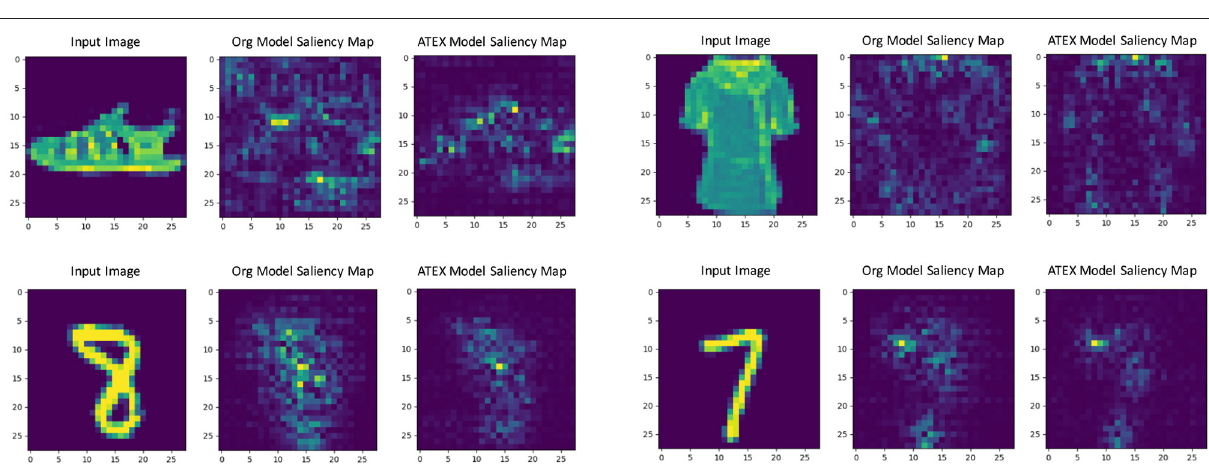
Frontiers in Big Data |